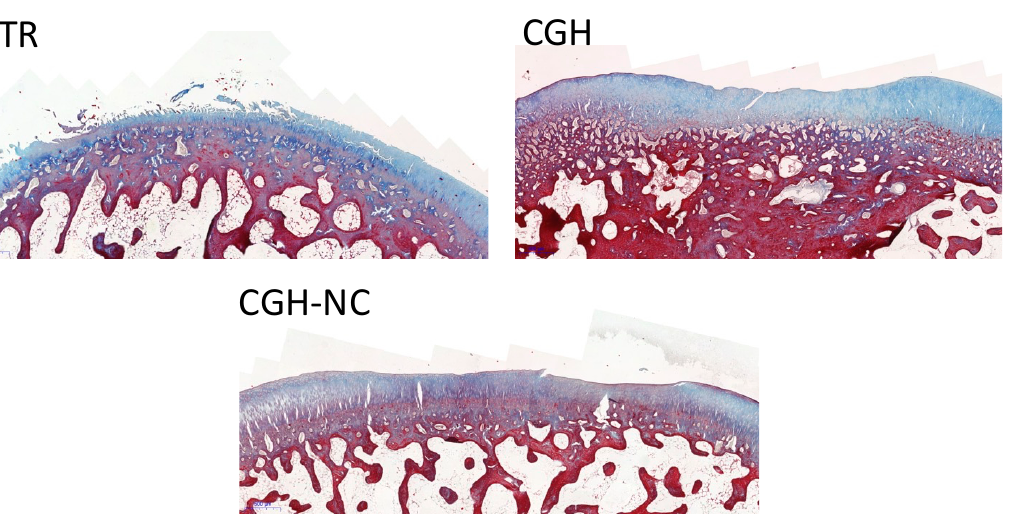
Figure 6. Histological sections of cartilage and subchondral bone (2x) using Masson’s trichrome stain of the different treatment groups. The different images show articular cartilage erosion, different extracellular matrix stains and subchondral bone structure changes.